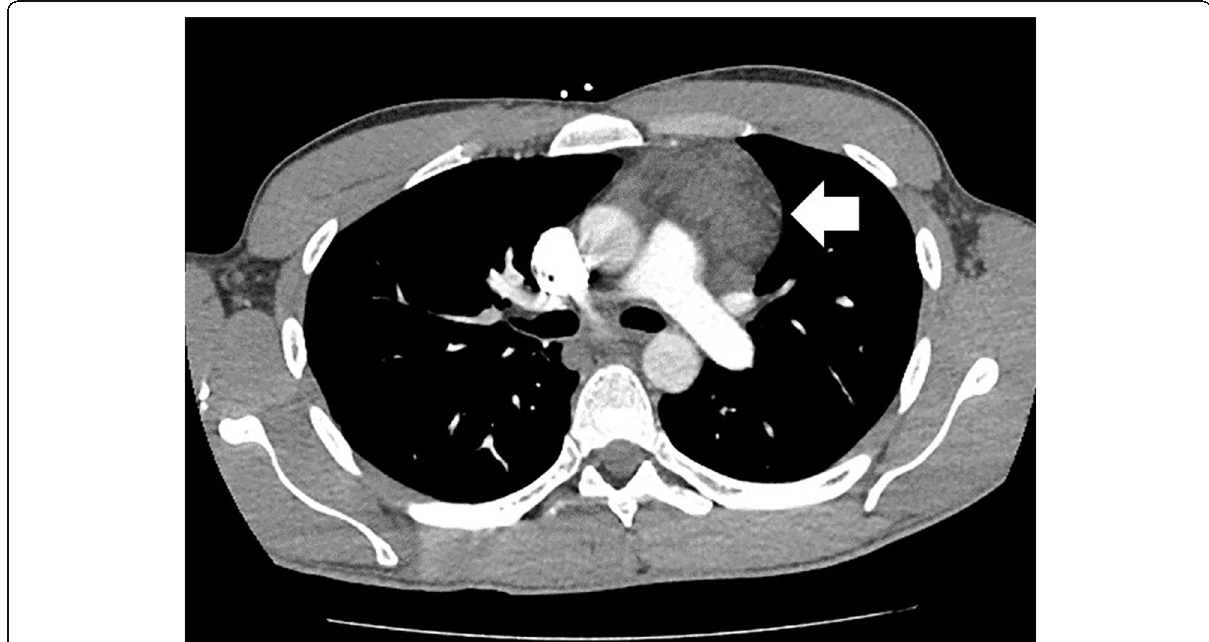
Fig. 1 Low density anterior mediastinal mass (white arrow) identified on contrast enhanced